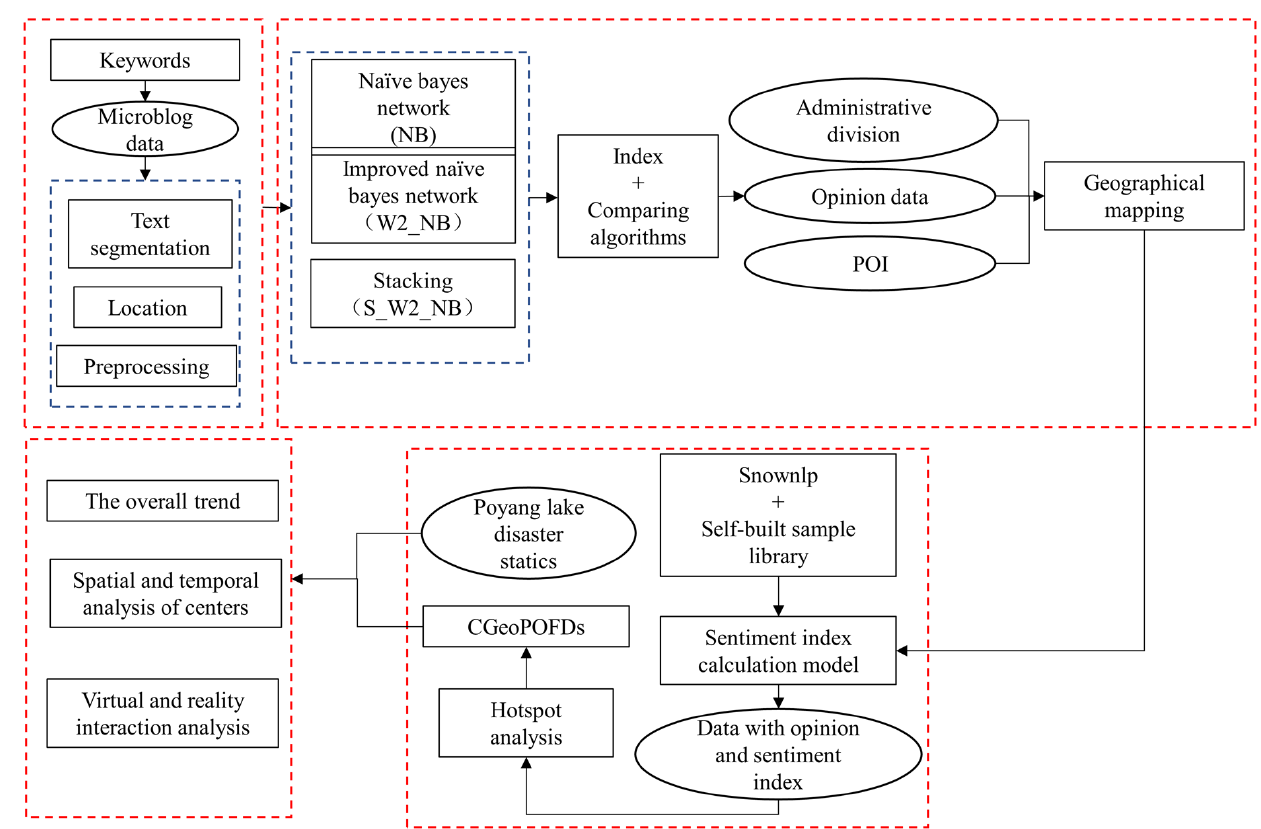
Figure 2. The model used to identify and analyze CGeoPOFDs. The red boxes show the different steps and reflect the inner processes.